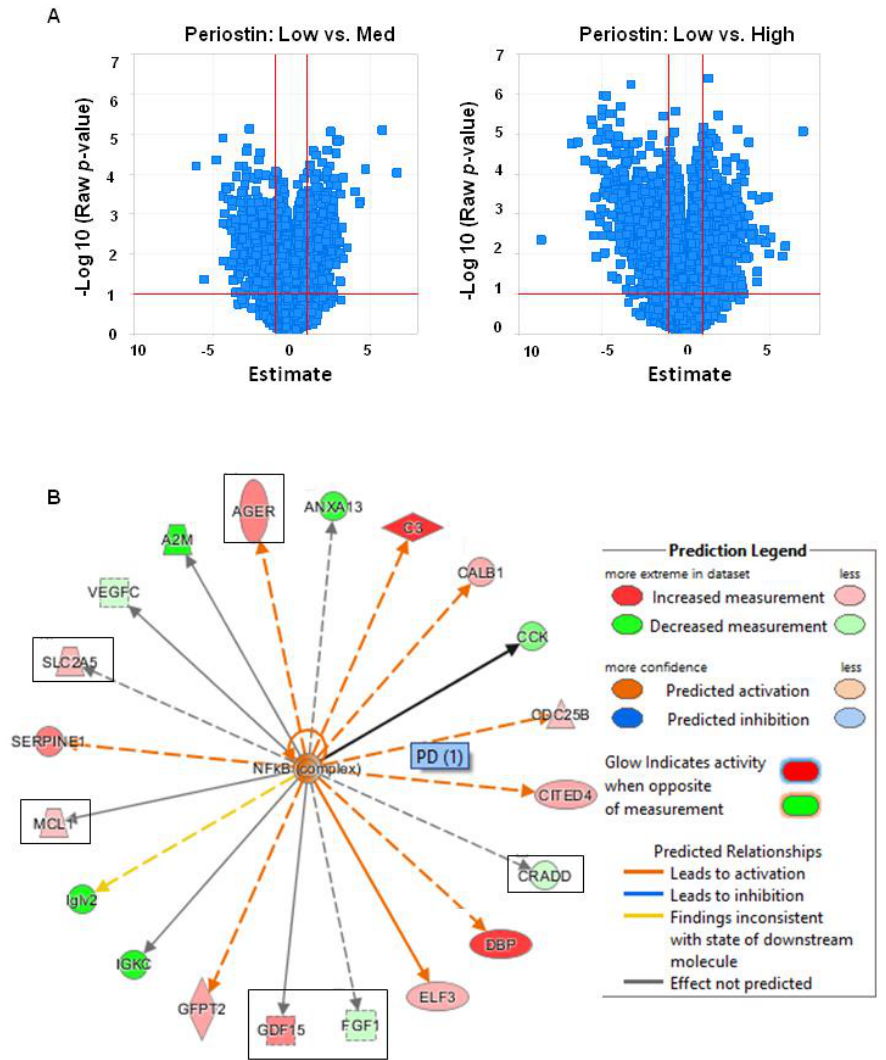
Figure 3. High periostin levels are associated with an activation of the NF- κ B pathway. Volcano plots of differential gene regulation “low” versus “medium” and “low” versus “high” periostin expression. The log p -value for each gene is shown over the fold change in the expression (FKPM). The cut-off lines represent a p -value of 0.05 and a fold change of − 2 or 2 ( A ). NF- κB mediated gene regulation ( B ).